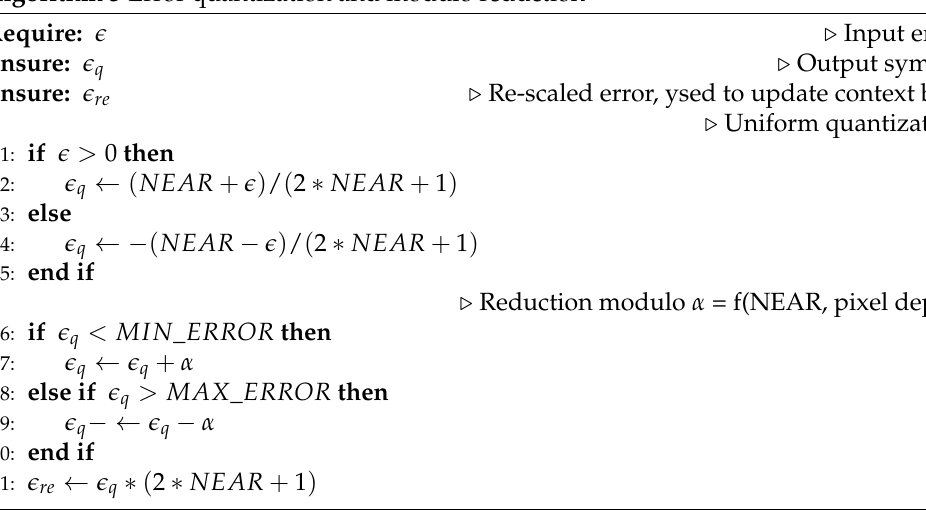
Algorithm 3 Error quantization and modulo